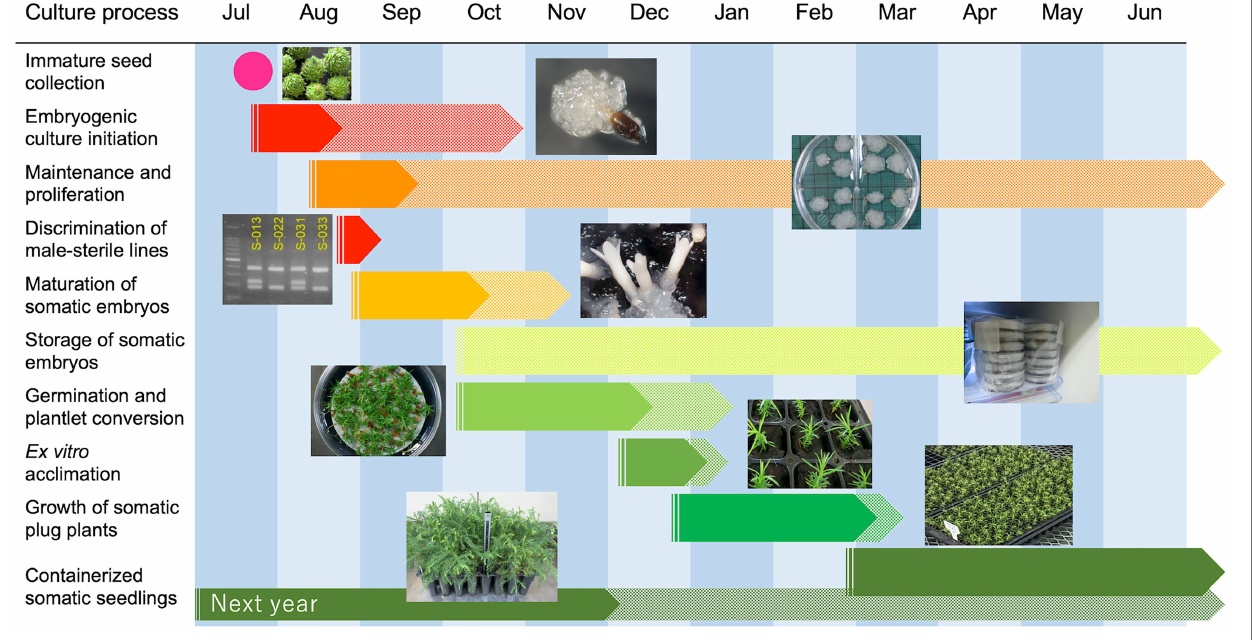
FIGURE 10 | A representative example schedule for the propagation of pollen-free sugi ( C. japonica ) via somatic